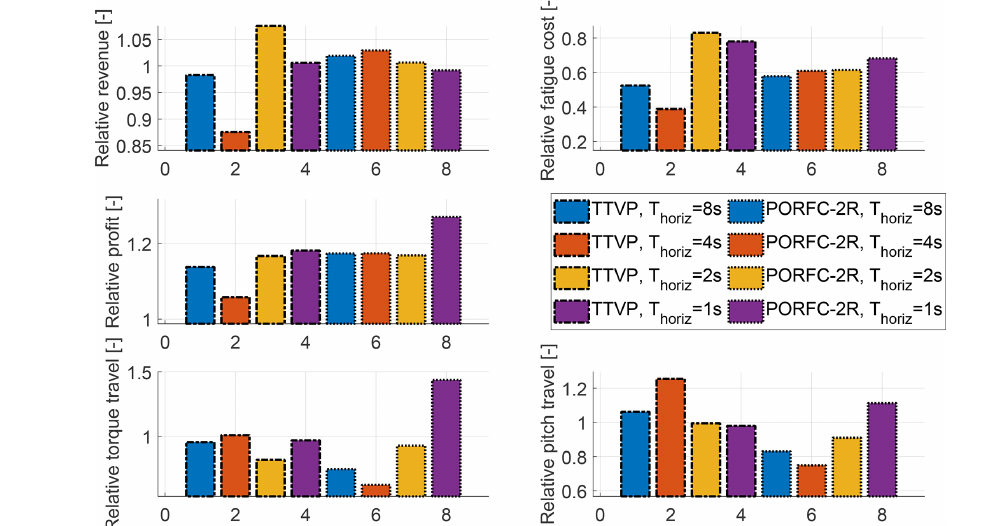
Figure 14. Weibull-weighted KPIs of the “perfect prediction” scenario normalized with respect to the individually corresponding KPIs of the “perfect persistence” scenario with the same MPC formulation and horizon length.